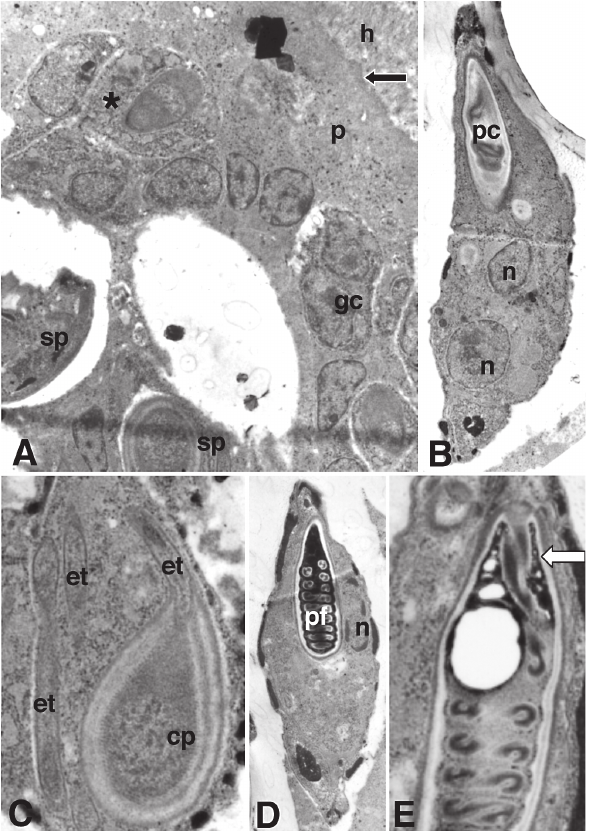
Fig. 4. – Electron micrographs of Myxobolus cuneus n. sp. A - sec- tion of a plasmodium (p) showing the plasmodial wall (arrow), host tissue-connective tissue capsule (h), disporoblastic pansporoblast (*), generative cells (gc) and fragments of young spores (sp). 7970 × . B - longitudinal section of a young spore showing the polar cap- sule (pc) and binucleated sporoplasm cell (n). 10133 × . C - early capsulogenic stage with the capsular primordium (cp) attached to the external tube (et). Note also two longitudinal sections of the external tube. 12926 × . D - longitudinal section of a nearly mature spore showing the polar filament (pf) within the polar capsule and the nucleus (n) of the capsulogenic cell. 7546 × . E - longitudinal section showing details of the anterior end of a polar capsule (arrow). 15920 × .